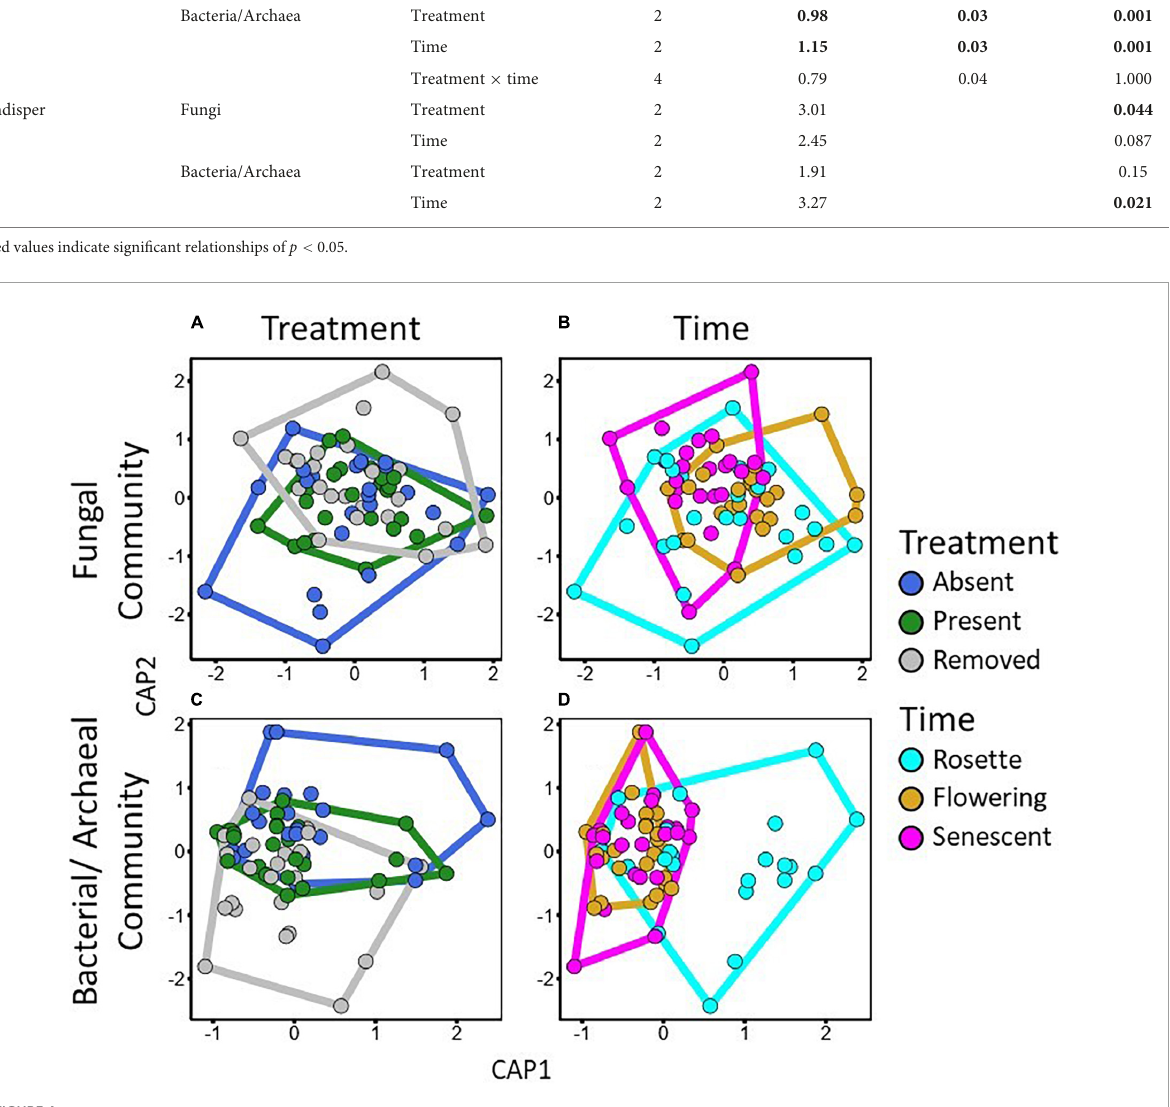
FIGURE4 Constrained principal correspondence ordinations conditioned on site for Bray-Curtis dissimilarities of relativized ASV count numbers for fungal (A,B) and bacterial/archaeal (C,D) communities. Polygons represent convex hulls indicating the extent of each treatment group for garlic mustard treatment (A,C) and time point (B,D) . CAP 1 and 2 for fungal communities explain 11.7 and 9.0% of variation in community dissimilarity, respectively, and CAP 1 and 2 for bacterial/archaeal communities explain 3.5 and 3.0% of variation in community dissimilarity,